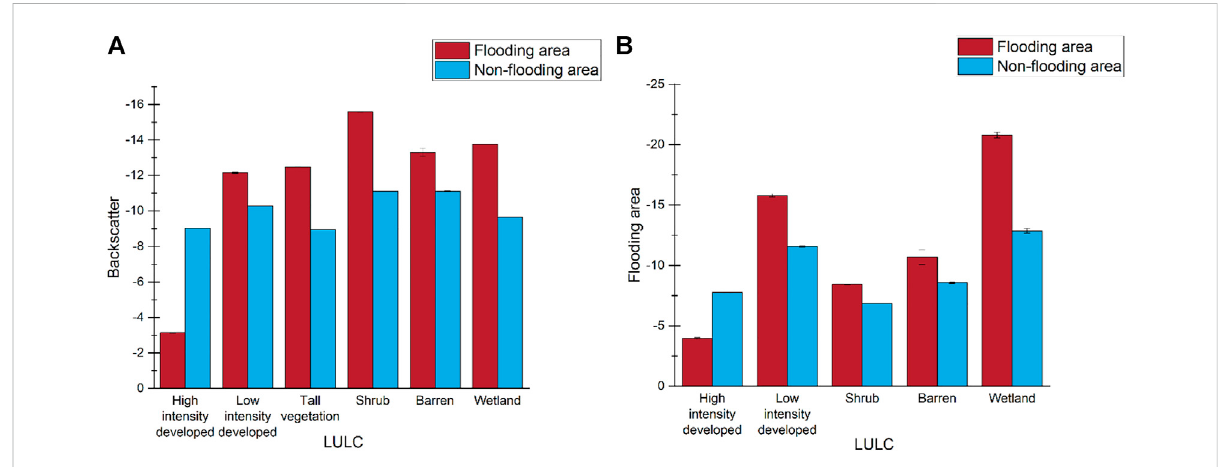
FIGURE 3 Average backscatter in fl ooding versus non- fl ooding areas for (A) Houston and (B)